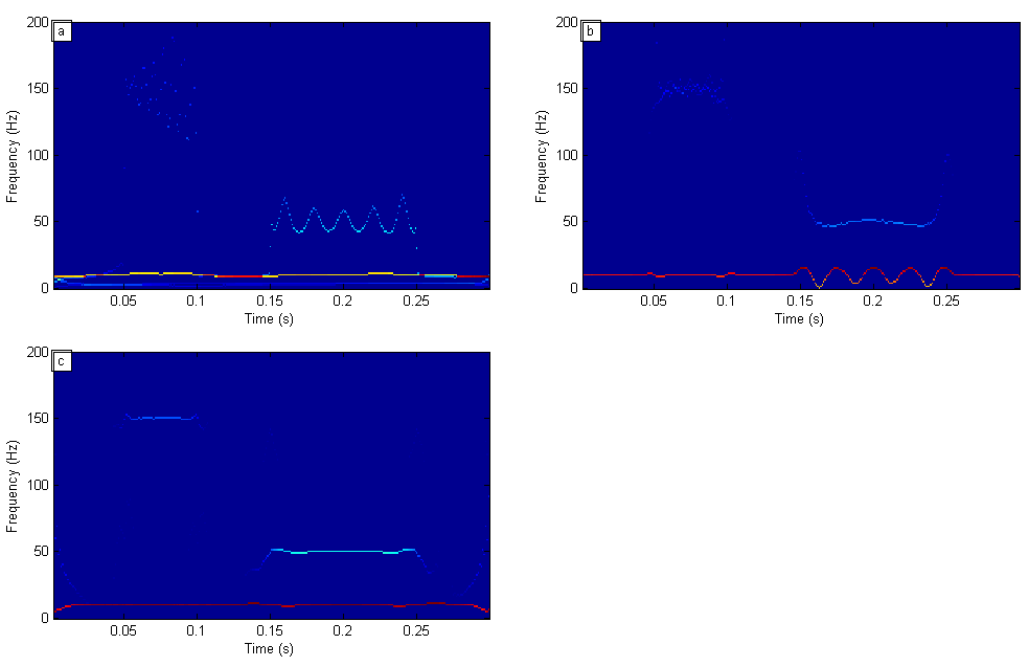
Figure 4. Frequency division section: ( a ) frequency division section based on empirical mode decomposition (EMD); ( b ) frequency division section based on ensemble empirical mode decomposition (EEMD); ( c ) frequency division section based on variational mode decomposition (VMD).